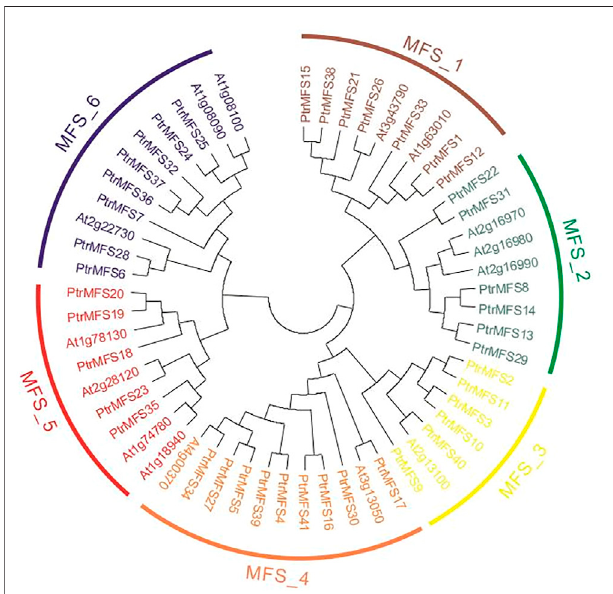
FIGURE 1 | Phylogenetic analysis of MFS proteins in poplar and Arabidopsis. The dendrogram of 56 MFS proteins was performed by MEGA5 withtheMLmethodbasedonJTT+G+Fmodel.Differentgroupsaremarked with different colors.